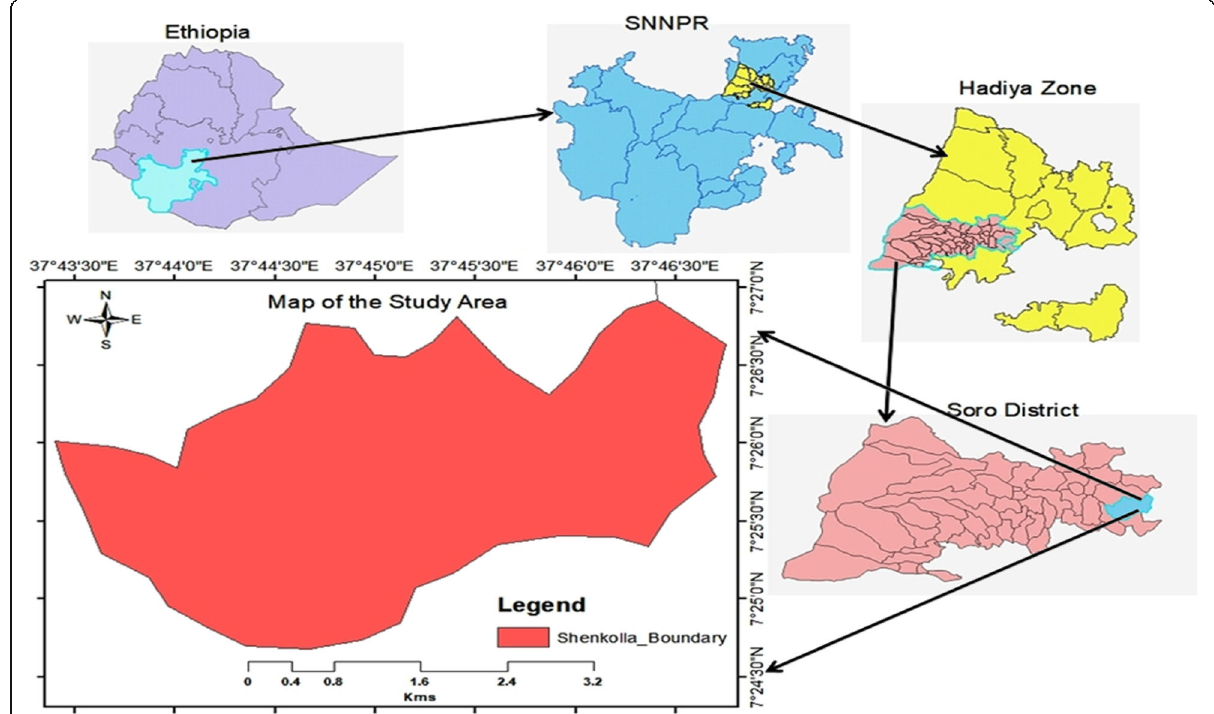
Fig. 1 Map of the study area within the southern region of Ethiopia